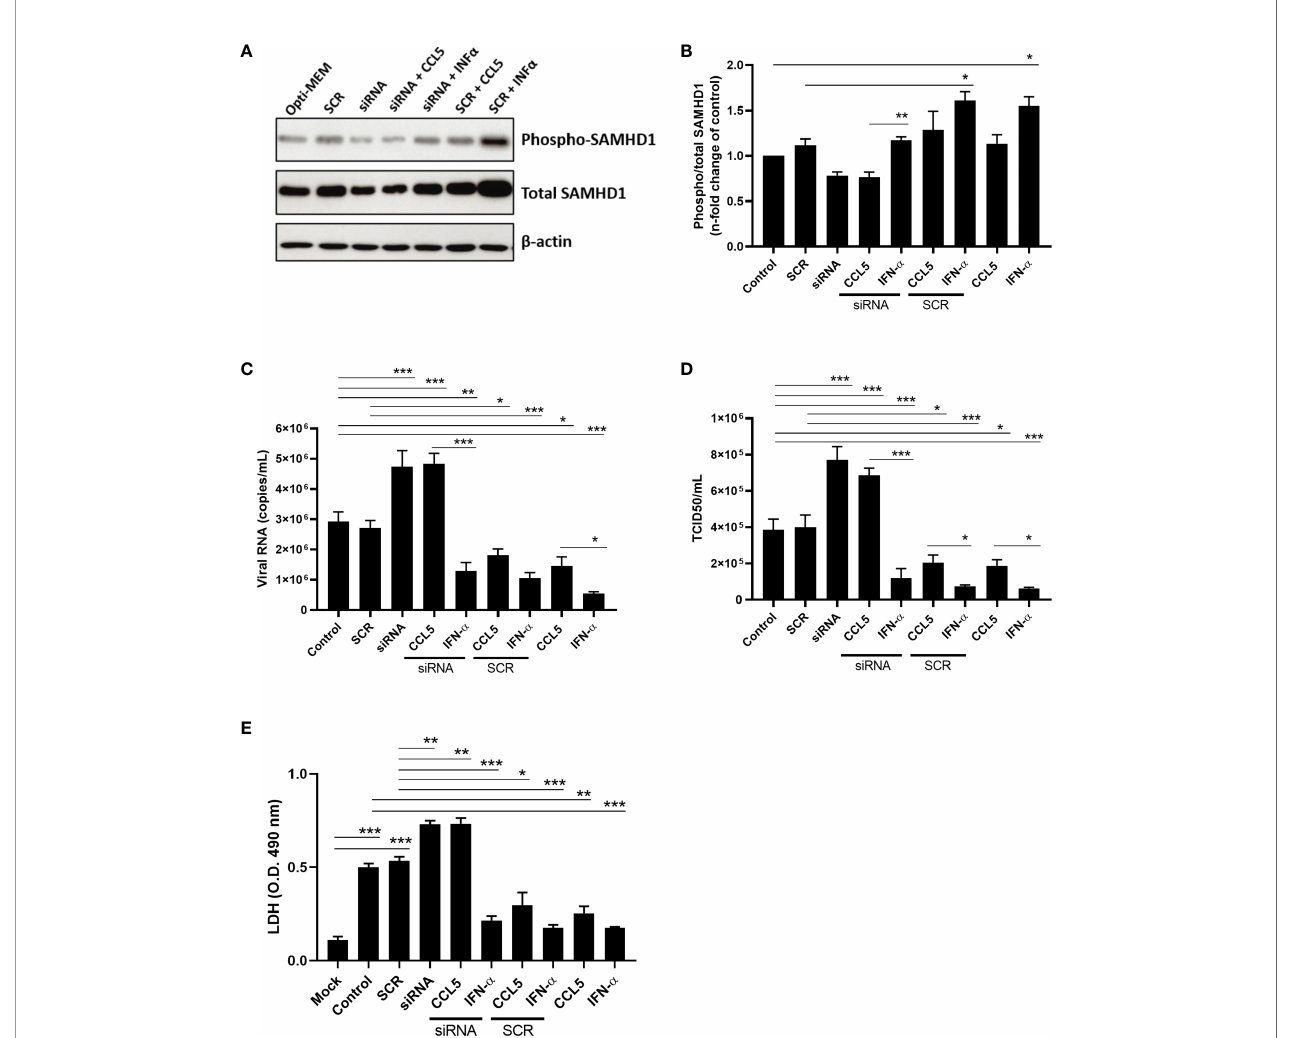
FIGURE 3 | SAMHD1 knockdown elicits in fl uenza A replication and abolishes CCL5 inhibitory effect on viral replication. A549 cells were transfected with siRNA for SAMHD1 or its scramble sequence at a concentration of 100 nM in Opti-MEM, using Lipofectamine 2000. At 6 hours post transfection, A549 cells were exposed or not to CCL5 (15 ng/mL) or IFN- a (10 ng/mL). After 18 h of exposure (A, B) , monolayers were lysed with RIPA buffer for western blot assay to SAMHD1 and b -actin, as a housekeeping protein, or (C, D) infected with in fl uenza A virus at MOI 2. At 24 hpi, supernatants were harvested for extraction of viral RNA and the viral titer measured through qRT-PCR (copies/mL) and by TCID 50 assays. (E) Supernatants of those cultures were also quanti fi ed for LDH activity, as a marker of cell death. Data were obtained from 3 independent experiments with technical duplicates. *p < 0.05, **p < 0.01 and ***p <